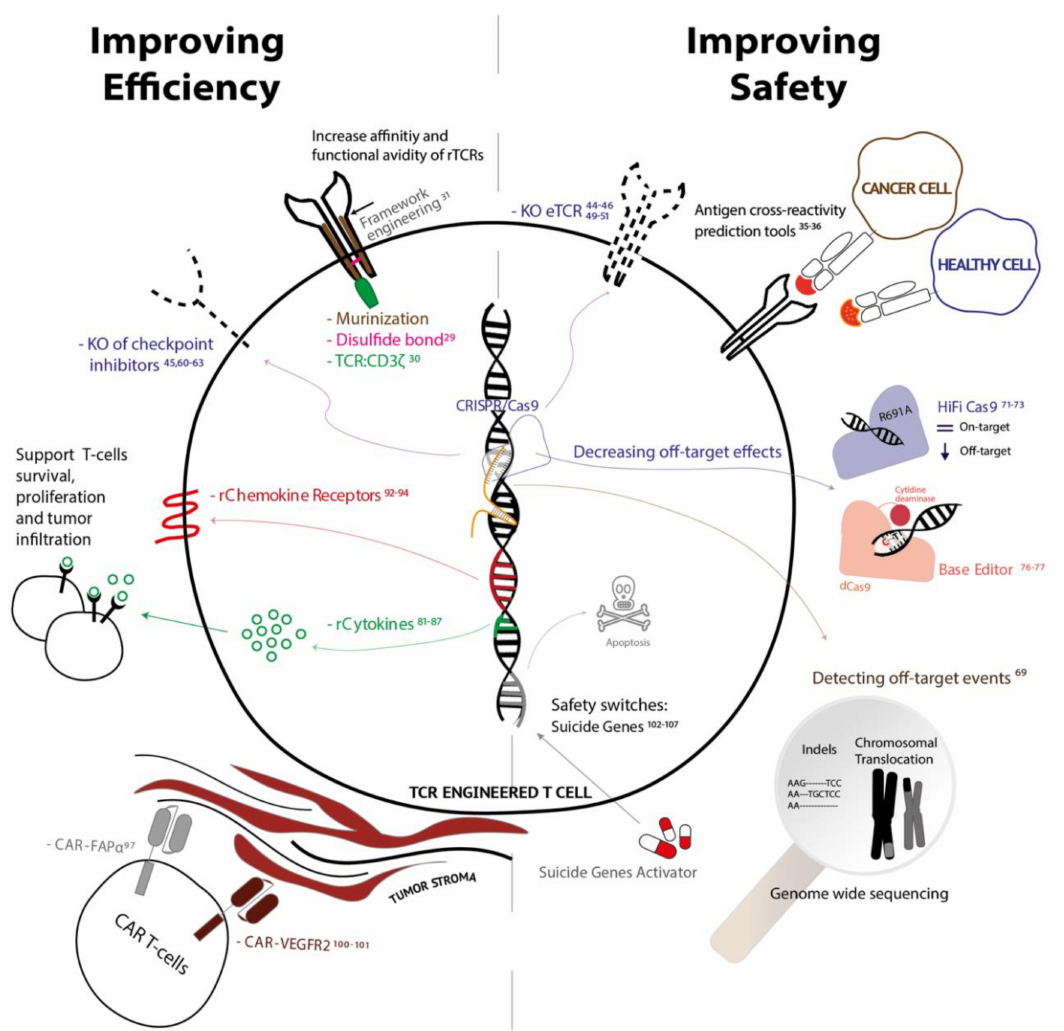
Figure 3. Summary of gene-augmentation and gene-editing strategies to improve e ffi ciency (on the left) and safety (on the right) to treat solid